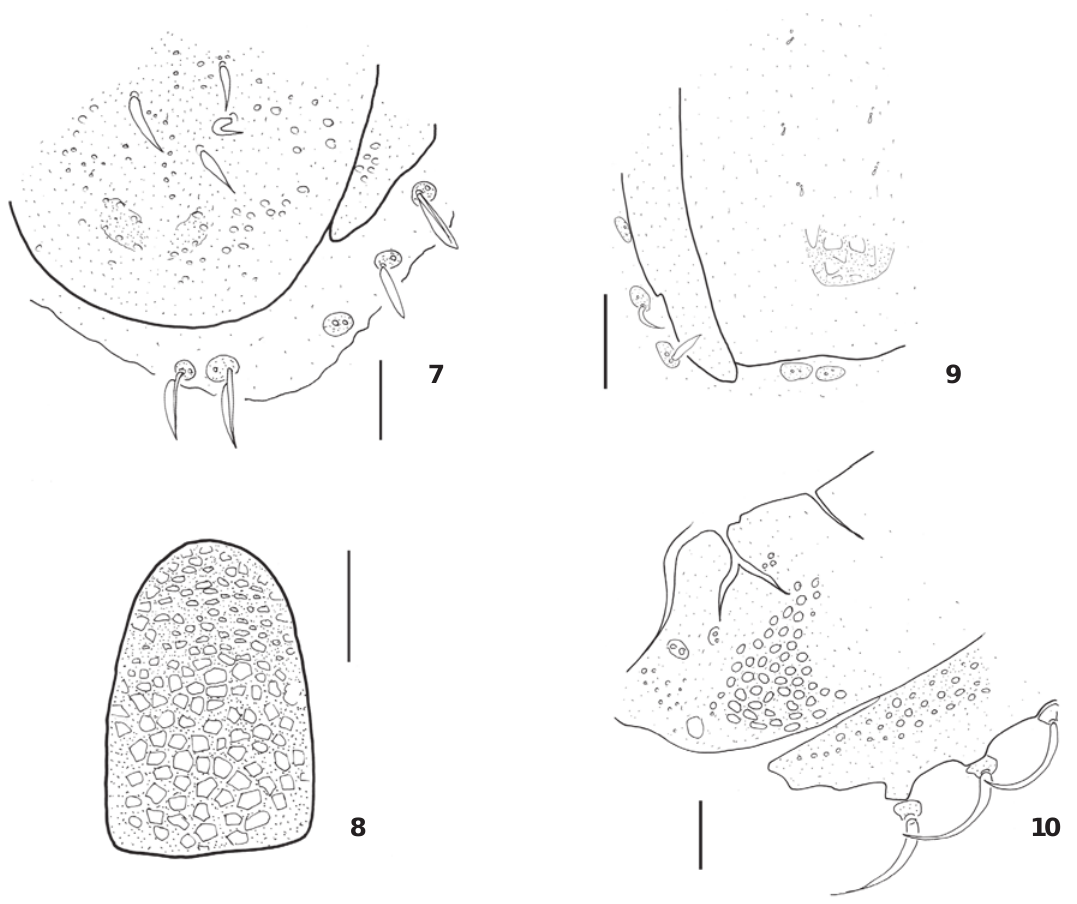
Short description. Dorsal and marginal shields bear alveo- lar ornamentation. All dorsal setae short and phylliform, mar- ginal setae long and setiform, on caudal region longer than oth- ers (Fig. 10). Sternal shield without ornamentation, ventral shield with pattern on lateral and caudal parts. Sternal and ventral se- tae smooth and needle-like. Female linguliform genital shield without anterior process and without ornamentation.